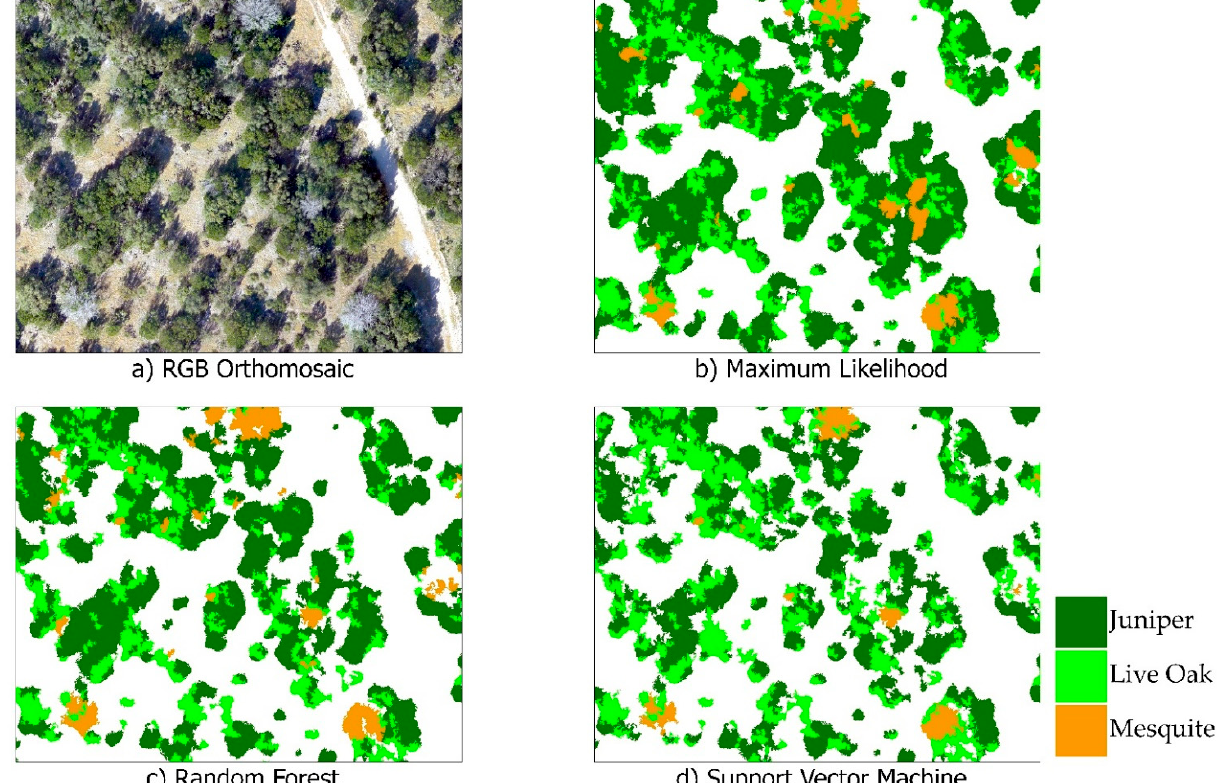
Figure 7. A comparison of the 3 traditional and classical machine learning algorithms used to classify the woody plant species in our study area. ( a ) The 10 cm orthomosaic. ( b ) ML tended to overestimate mesquite cover, as well as total tree cover with what was generally shadow. ( c ) RF was similar to ML, overestimating tree cover with shadow. ( d ) Overall, SVM was more robust in parsing between shadow and canopy cover for the three tree species.